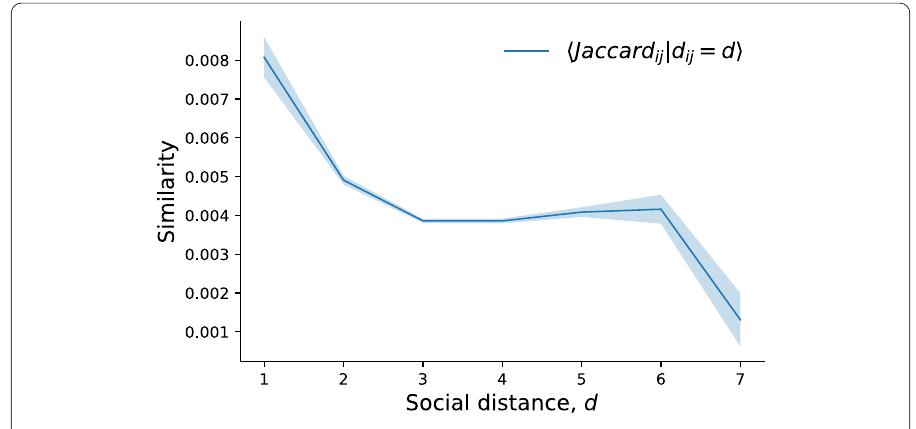
Figure 17 Average Jaccard similarity score for different social distances between investors. Here, the social distance is the number of links between a pair of investors in the observable insider network. The light blue bands mark the Standard Error of the Mean